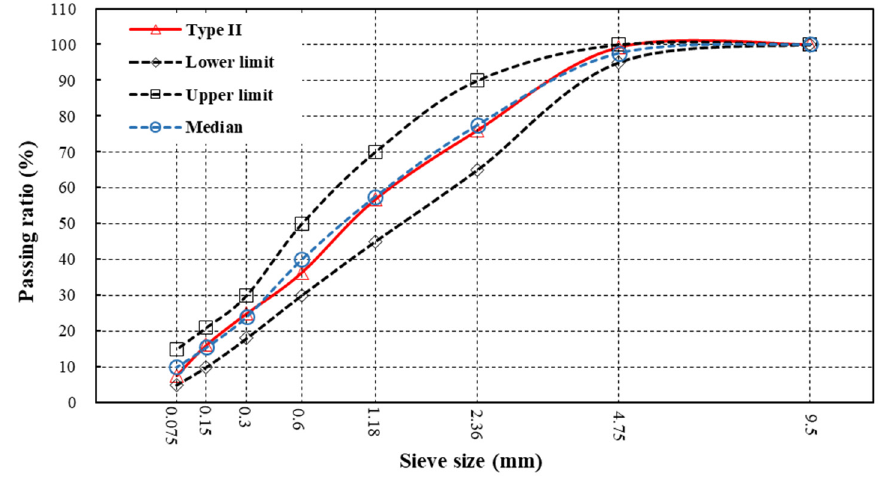
Figure 1. Gradation curve of Type II micro-surfacing samples.